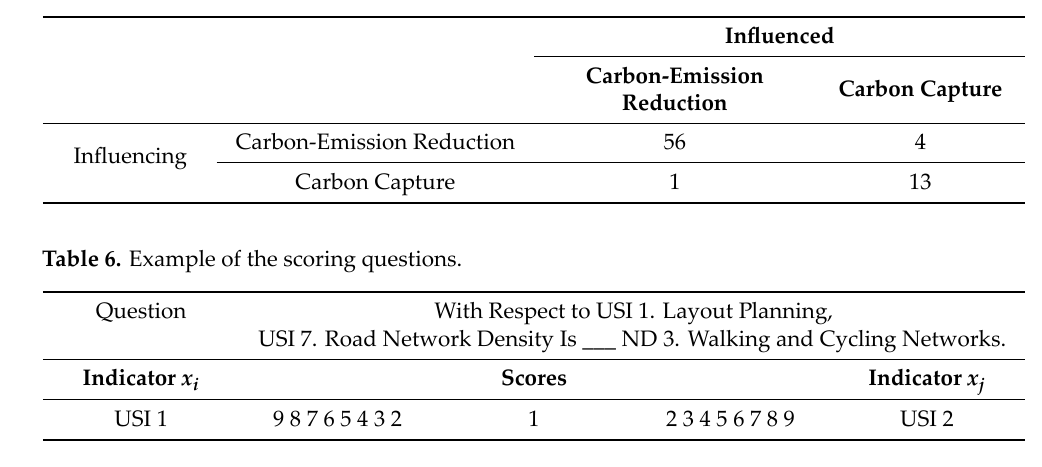
Table 5. The counts of pairs between indicators of the clusters.